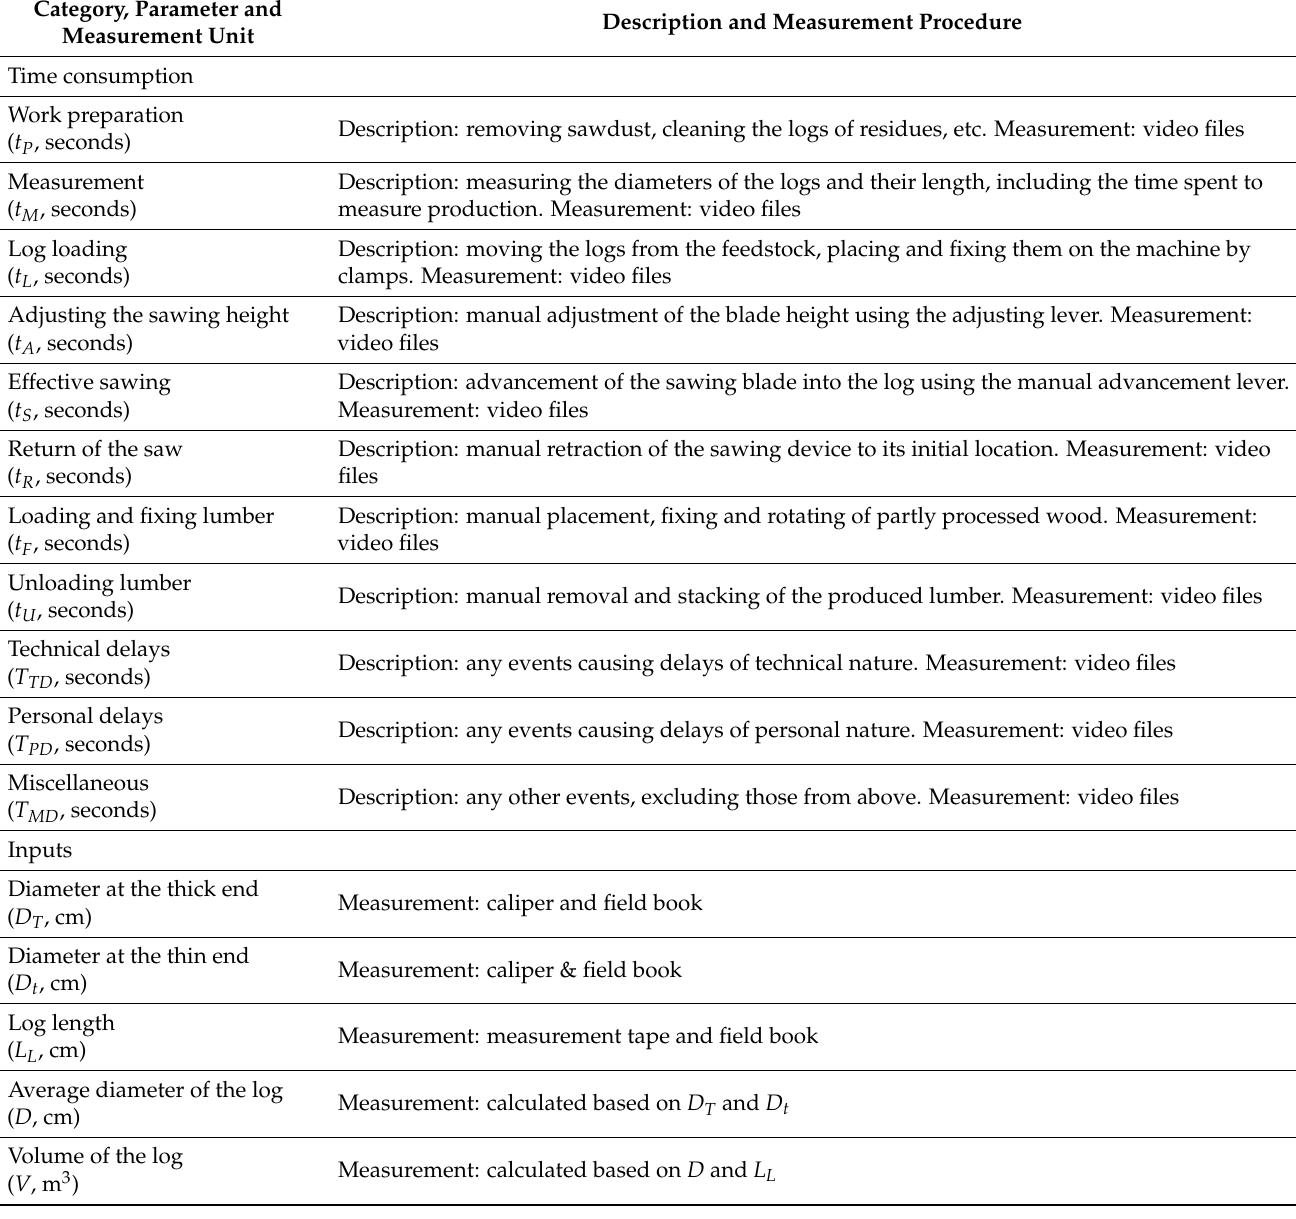
Description and Measurement